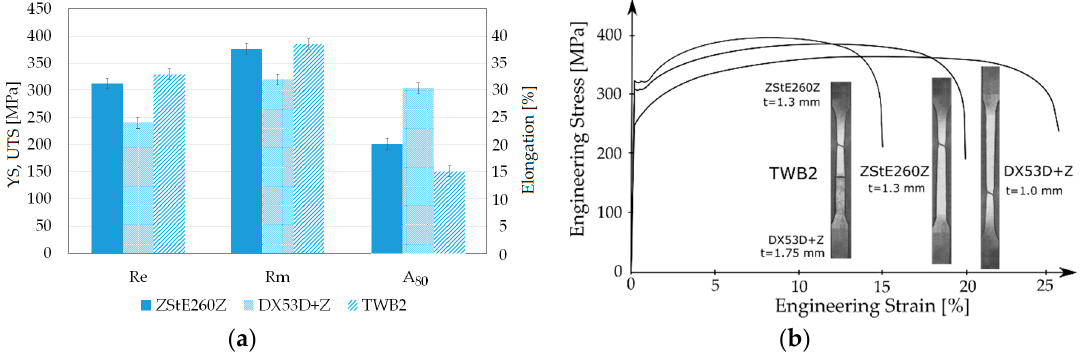
Figure 9. ( a ) The yield stress, tensile strength, and elongation of the base materials and TWB2; ( b ) the stress–strain curves of the base materials and TWB2.